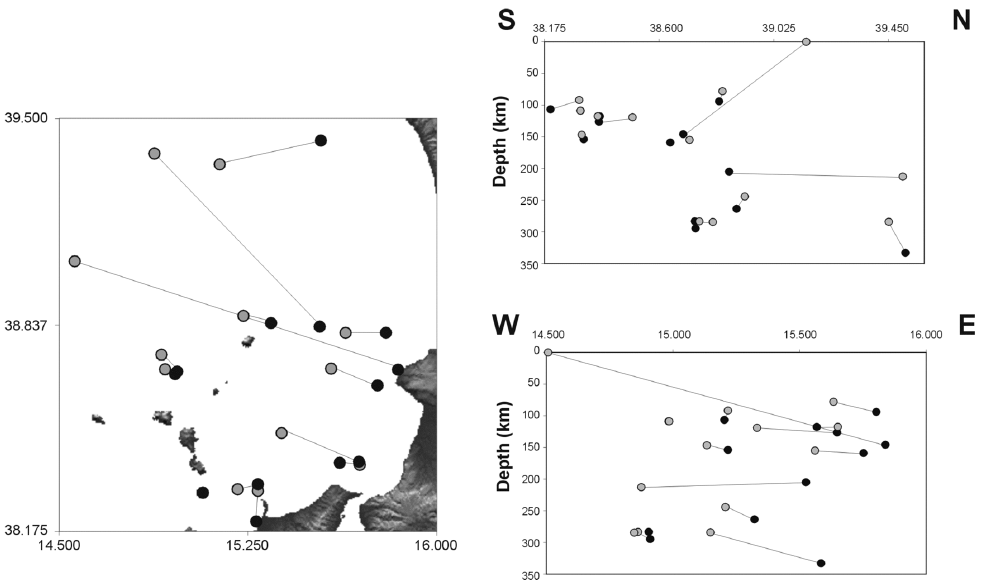
Fig. 4. Cluster 1 – Deep events. Grey circles represent the located events using the land-stations; black circles are the integrated locations. Black lines join the two different locations of the same event. On the right, S-N and W-E sections are presented.